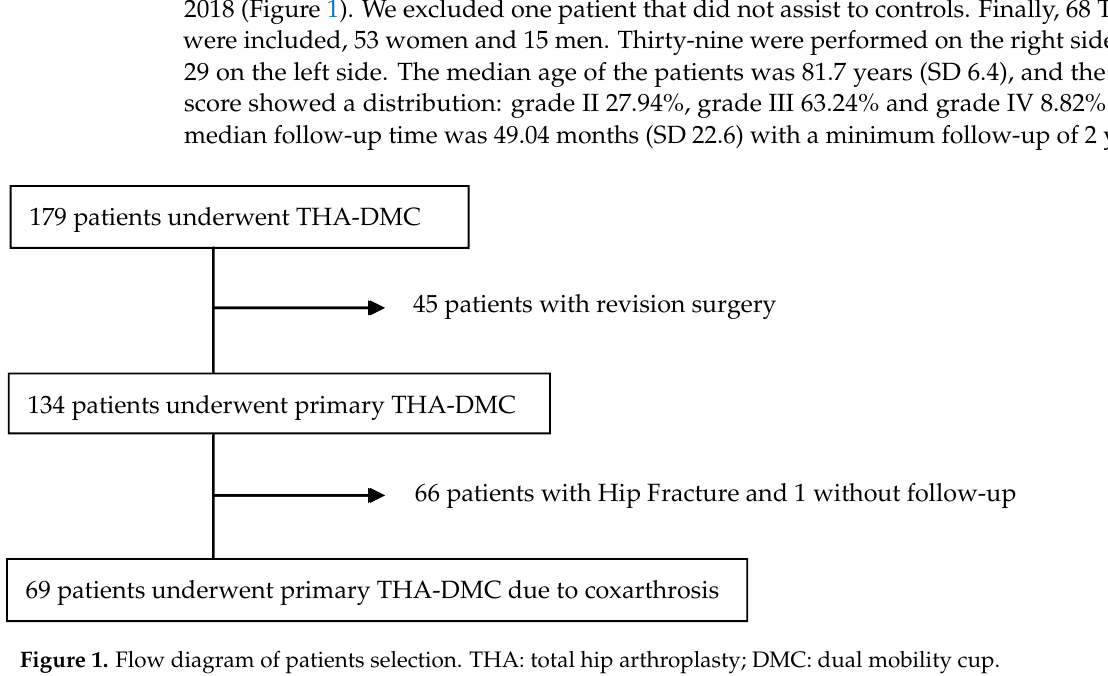
Figure 1. Flow diagram of patients selection. THA: total hip arthroplasty; DMC: dual mobility cup.